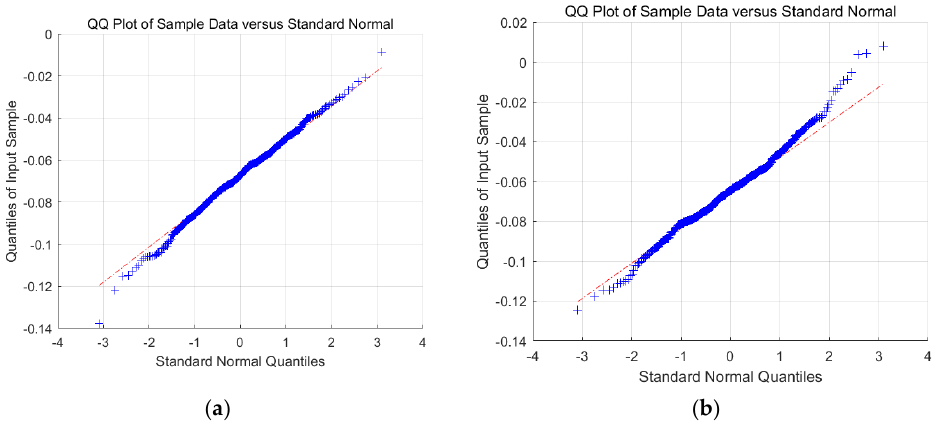
Figure 2. Quantile–quantile (QQ)-plot of a subcarrier ( a ) when the monitoring area is empty and ( b ) when the target stands at a location in the monitoring area.